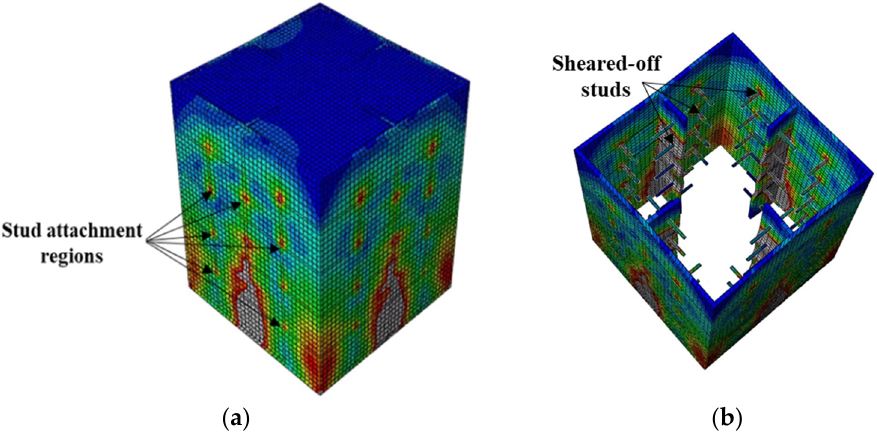
Figure 14. Typical failure mode of CFST columns with shear studs and rib connectors: ( a ) stress distribution and ( b ) failure mode.